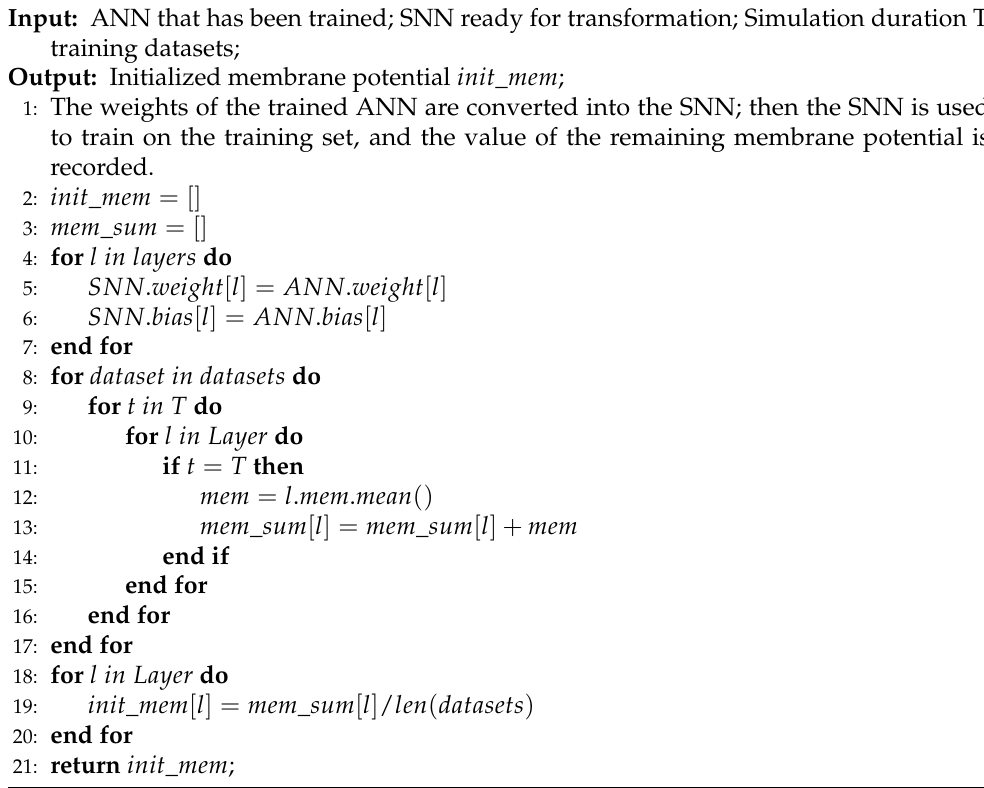
Algorithm 2 Initialized membrane potential based on training